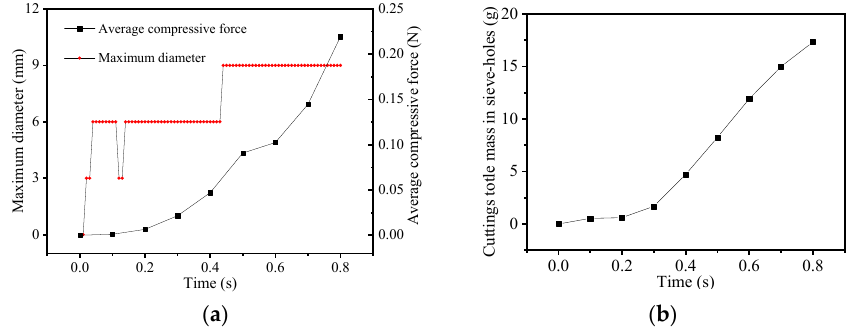
Figure 10. Average compressive force and total mass of drilling cutting variations over time. ( a ) Av- erage compressive force of drilling cuttings outside the drill pipe and the maximum diameter of the drilling cuttings entering into the sieve holes; ( b ) Drilling cutting total mass in the sieve